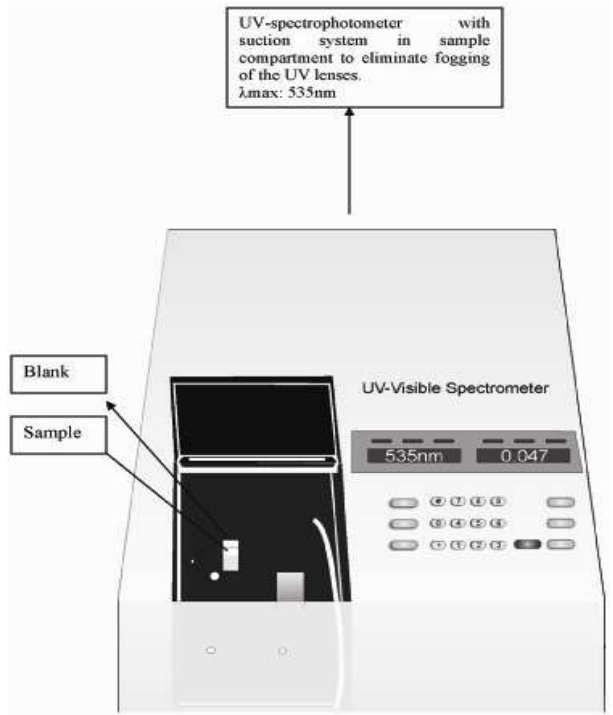
Figure 2: Suction System Attached to Spectrophotometer to Figure 2. Suction system attached to spectrophotometer to rectify Rectify Fogging Problem fogging